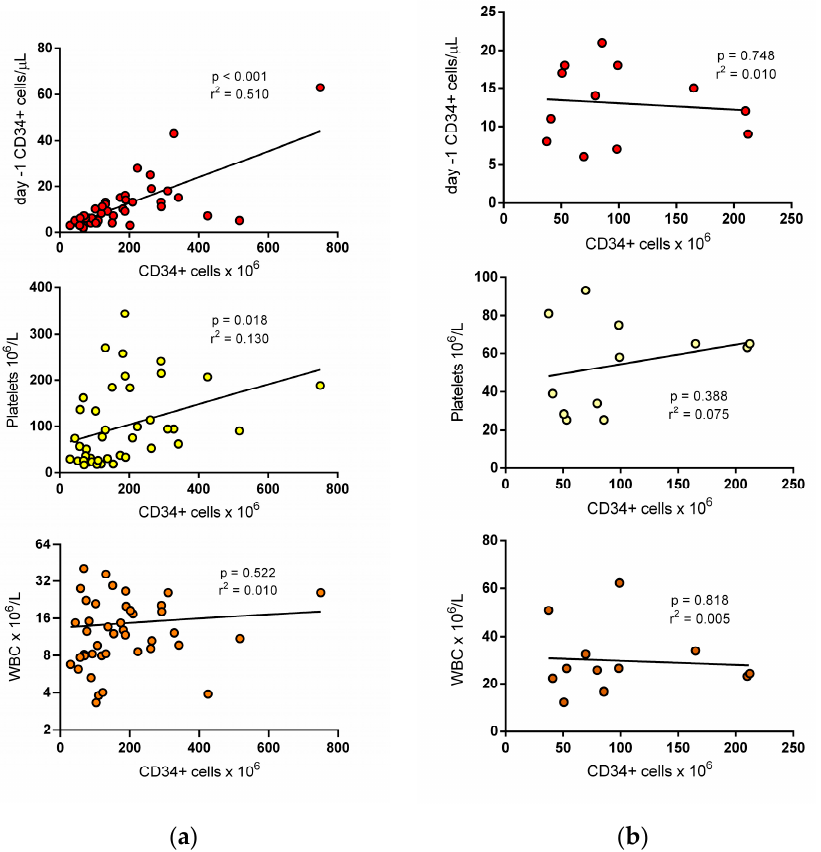
Figure 1. Correlation between CD34+ cell yield (normalized to 10 L of blood volume processed) and parameters recorded on Day -1. ( a ) The CD34+ cell yield at first collection showed a significant correlation with pre-apheresis CD34+ cell count and, to a lesser extent, with platelet count; there was no correlation with WBC count. ( b ) The CD34+ cell yield obtained at the second procedure showed no correlation with CD34+ cells, platelets, and WBC count recorded on the previous